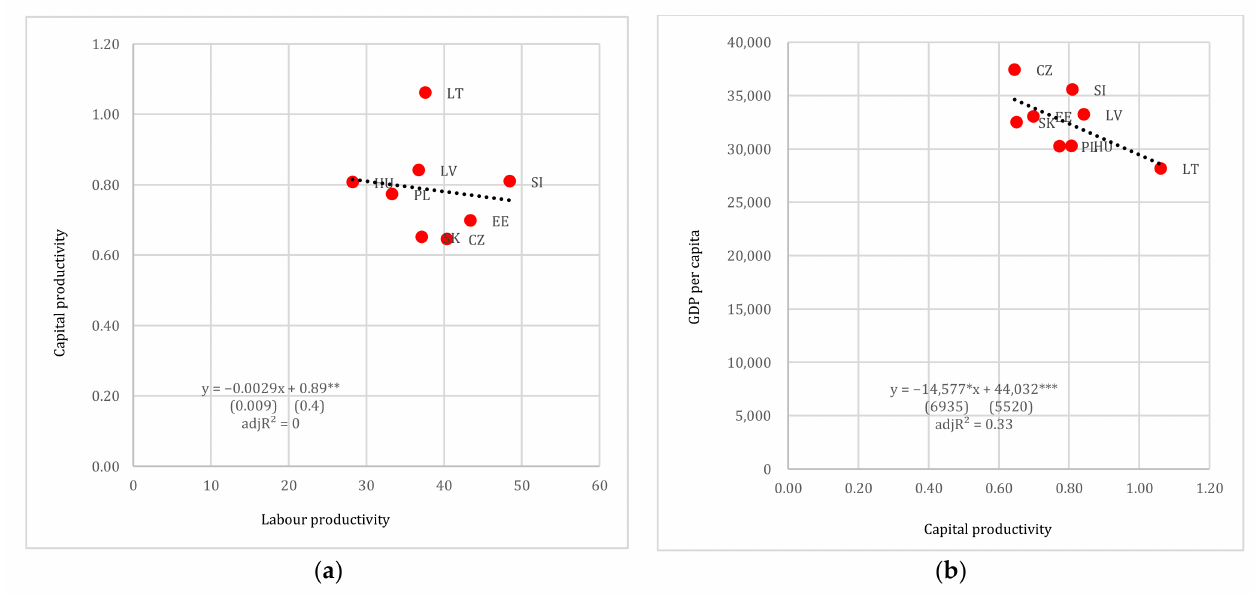
Figure 13. ( a ) Labour productivity vs. capital productivity and ( b ) capital productivity vs. GDP per capita (in USD pps), post-Soviet. Note: Standard errors reported in parentheses. *, **, *** denote 10%, 5% and 1% levels of statistical significance,